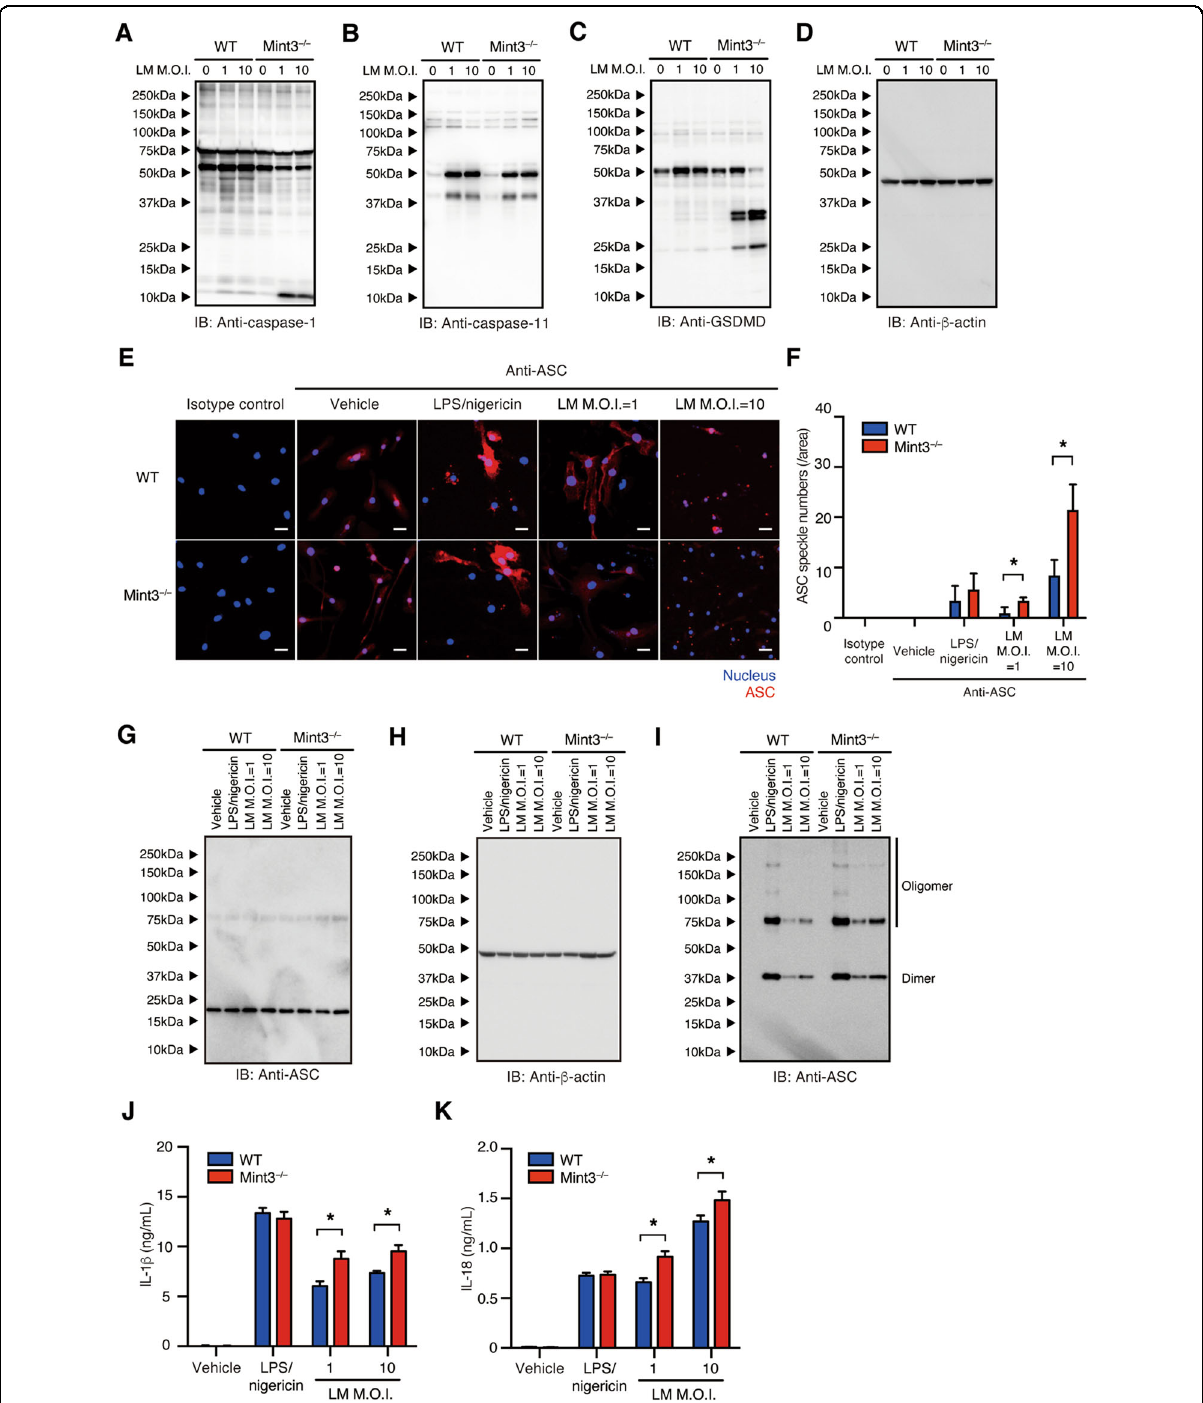
Fig. 4 Mint3 depletion promotes in fl ammasome activation in LM-infected macrophages. A – D In fl ammasome activation in WT or Mint3 – / –